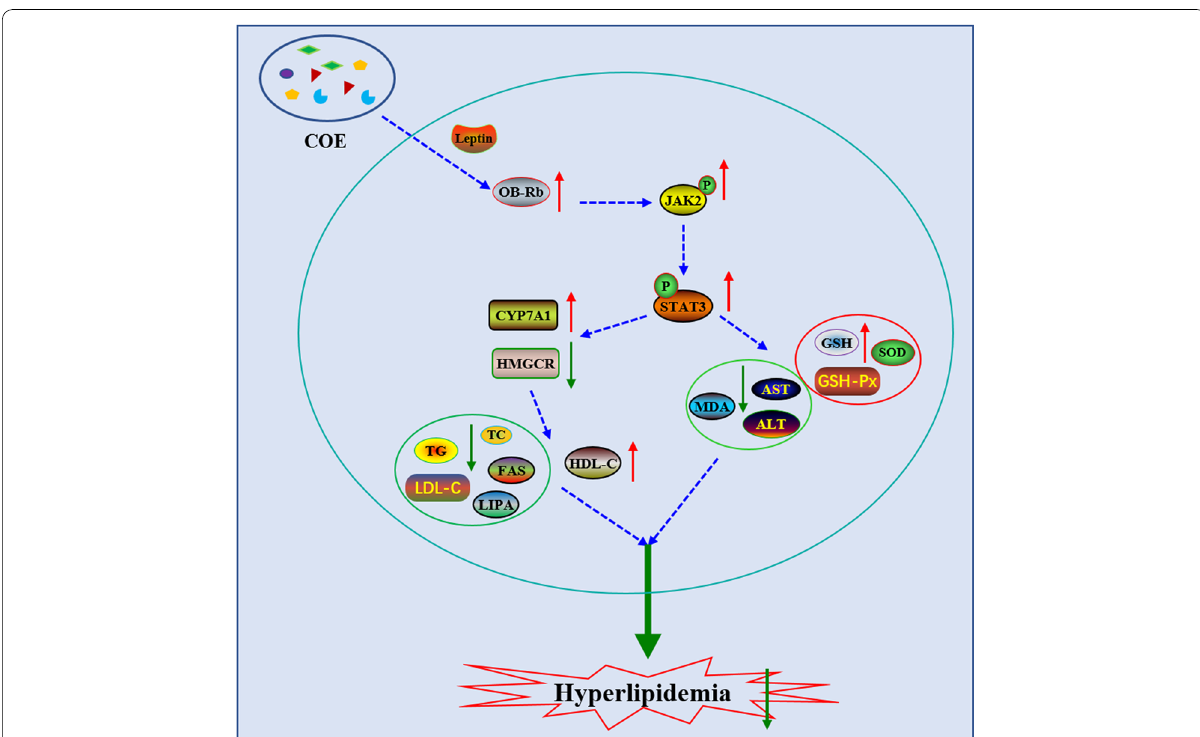
Fig. 8 Potential novel mechanism of COE in hyperlipidemia treatment. COE promotes the interaction between leptin and OB-Rb, which induces phosphorylation of JAK2 and STAT3. On the one hand, the activation of the JAK2/STAT3 pathway elevates antioxidase activities and improves liver function. On the other hand, phosphorylation of STAT3 regulates lipid metabolism based on CAP7A1 elevation and HMGCR reduction, finally alleviating hyperlipidemia in rats. : increase, : ↑ ↓